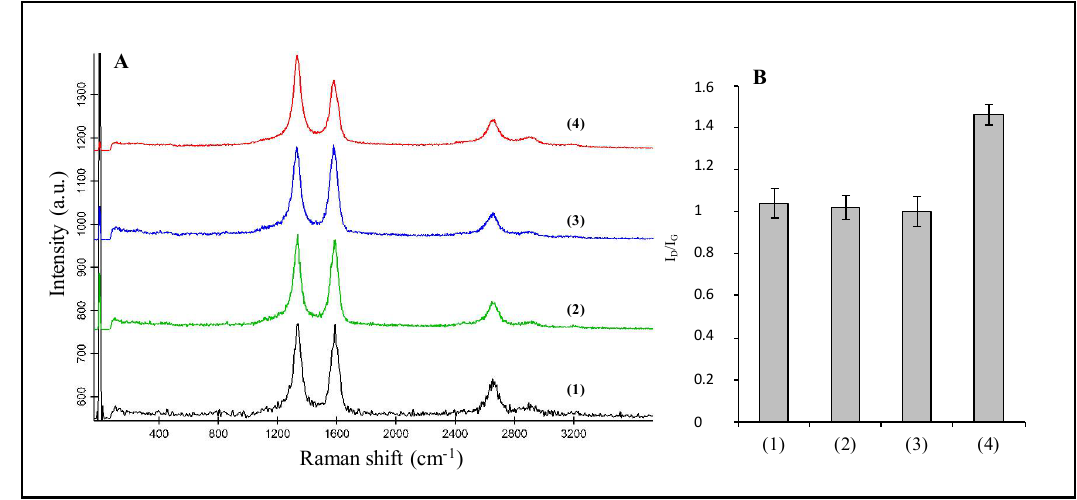
Figure 6. ( A ) Raman spectra of pristine SWNHs (1), SWNHs dispersed in chloroform followed by a rapid evaporation of the solvent without sonication (2) and with a previous sonication step (3), and the SWNH-monolith (4). ( B ) Plot of the average value of the intensity ratio of the Raman D and G bands calculated from the Raman spectra measured of the different materials. Spectra at different positions within each sample were acquired and the average value calculated (n = 5), with the error bars depicting the standard deviation within measurements.